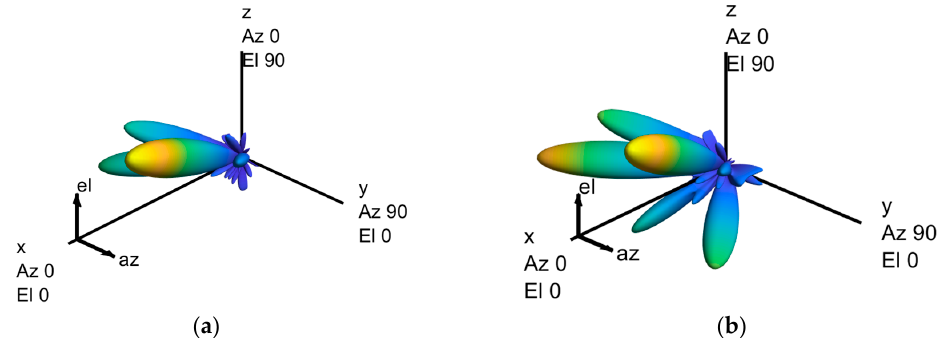
Figure 5. Beampattern of the access link: ( a ) Proposed HBF, 4 RF chains; ( b ) fully-digital beamforming (optimal).